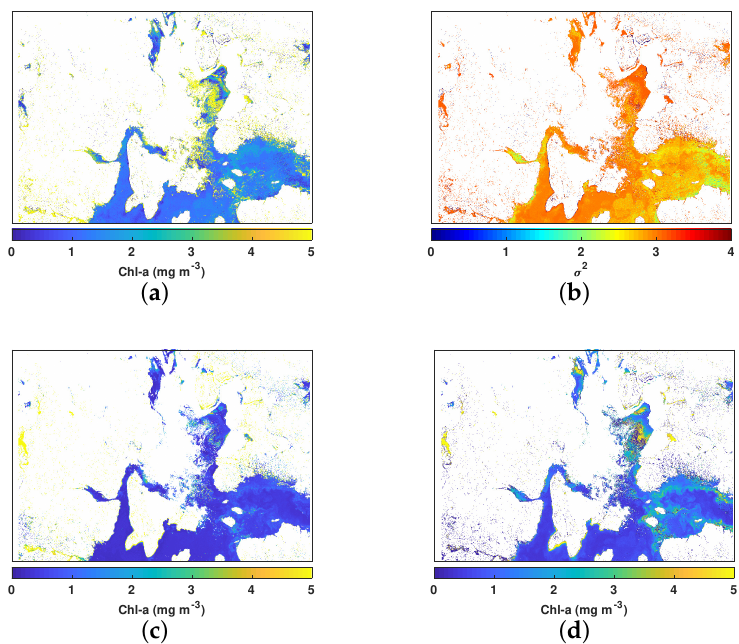
Figure A2. Estimated Chl-a in the Marginal Ice Zone: ML GPR Balaton model ( a ) and corresponding certainty map ( b ), NN ( c ) and OC4 ( d ). The unit of Chl-a is mg m − 3 .